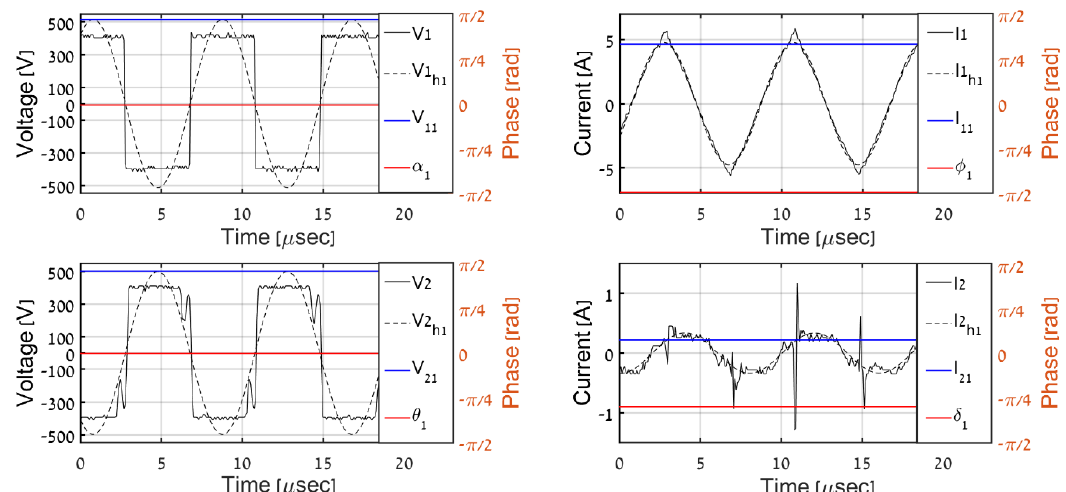
Figure 17. Experimental results, P O = 50 W.